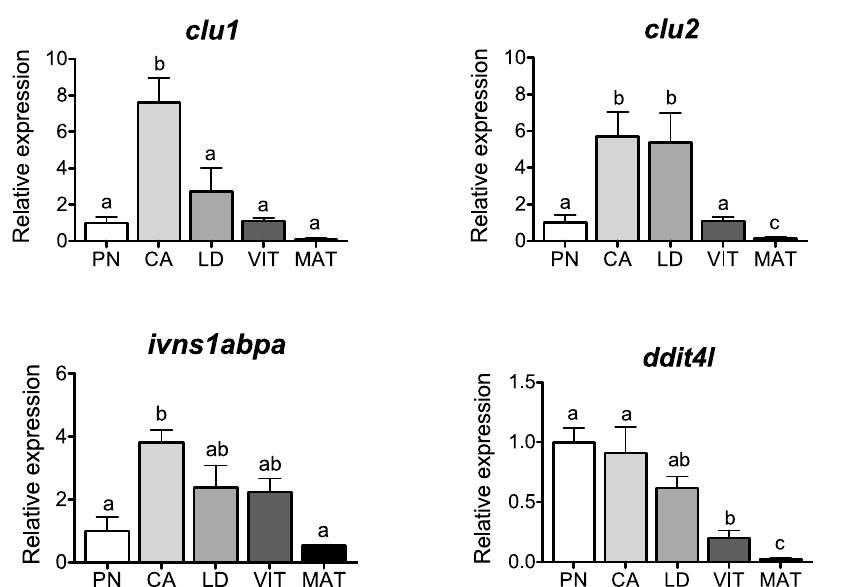
Fig. 3. Expression profiles of genes associated with cell survival during major stages of oogenesis in coho salmon. Messenger RNA levels were analyzed by qPCR and data were normalized to the geometric mean of four reference genes ( eef1a , ctsd , ctsz and actb ). PN, perinucleolus stage follicles; CA, cortical alveolus stage follicles; LD, lipid droplets stage follicles; VIT, mid-vitellogenic stage follicles; MAT, postvitellogenic/preovulatory stage follicles. Bars not sharing the same letter are significantly different (P , 0.05; n 5 4 fish/stage for PN-, CA-, LD-, and VIT-stages, n 5 3 fish for MAT-stage, mean ¡ SEM).